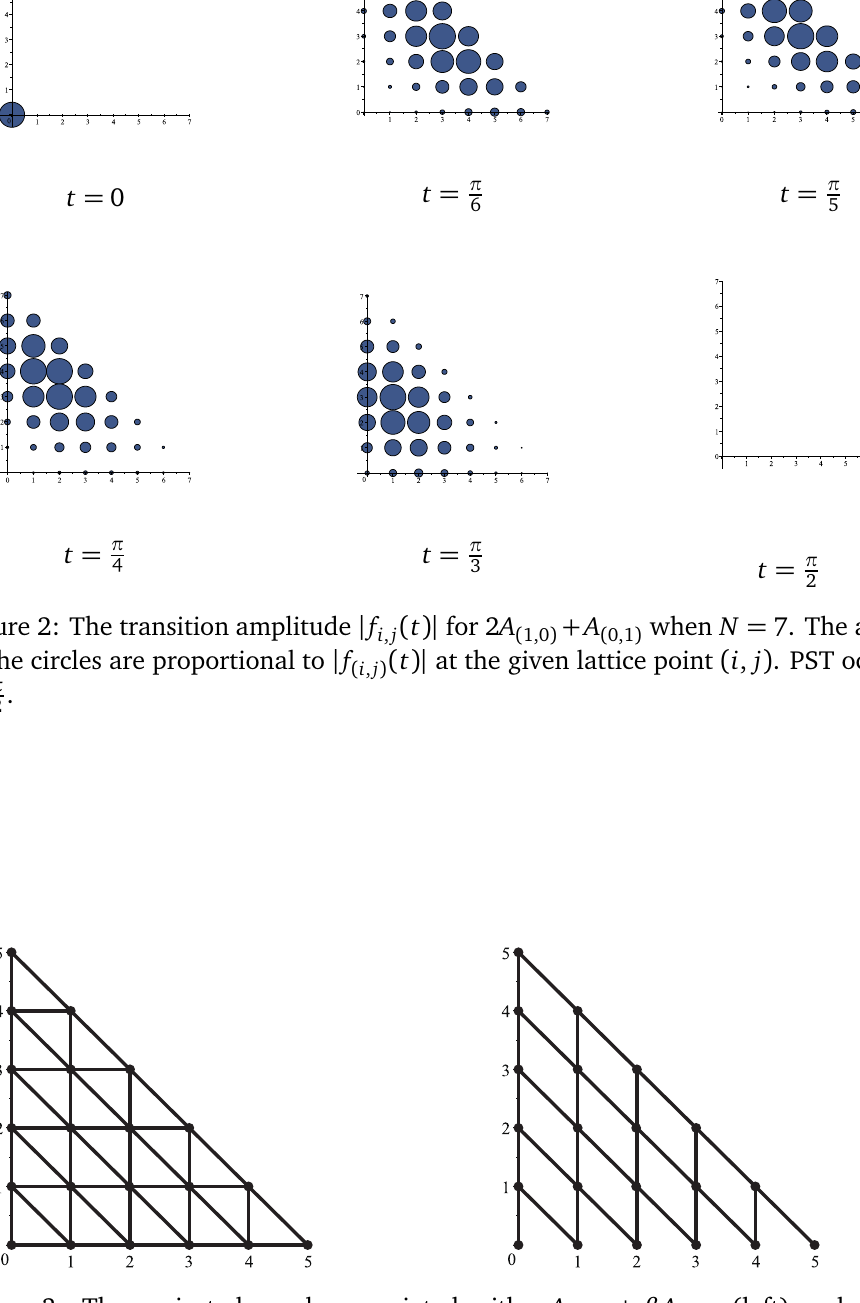
Figure 3: The projected graphs associated with α A ( (right) when N = 5. On the graph associated with A ( occurs at some time T